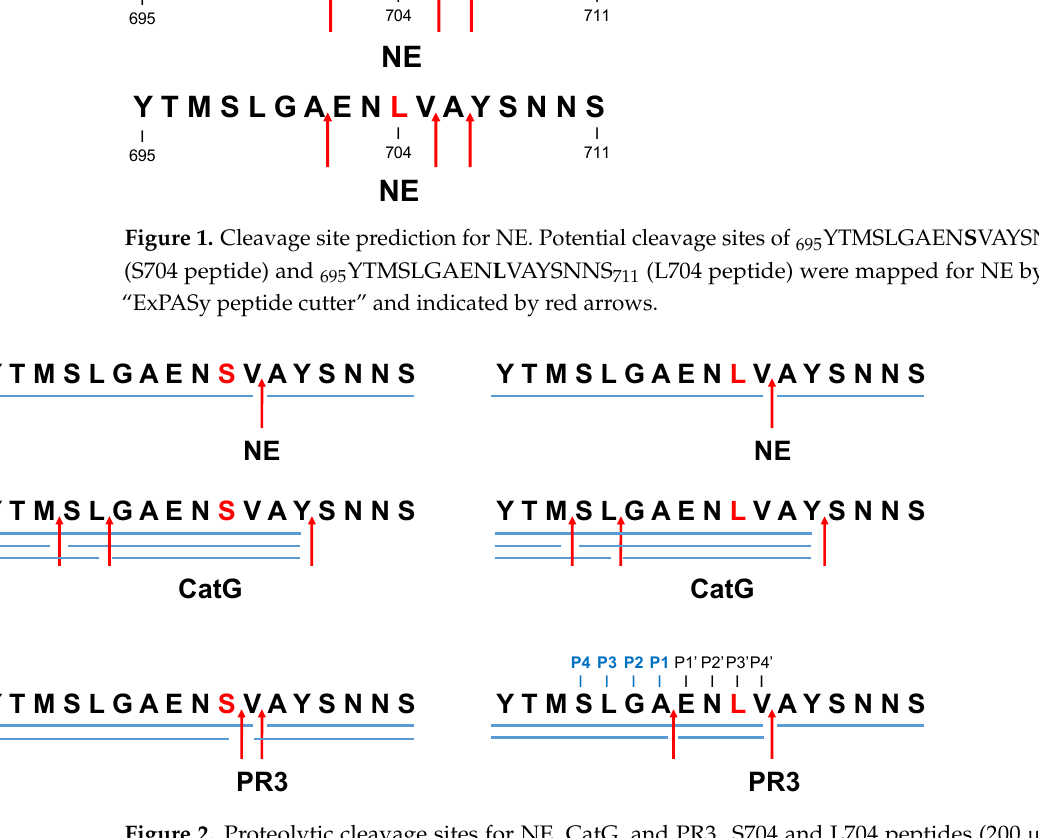
Figure 2. Proteolytic cleavage sites for NE, CatG, and PR3. S704 and L704 peptides (200 μ g/mL) were incubated with 4 μ g/mL of NE, CatG, or PR3 for 2 h at 37 °C. The hydrolysis of the peptide bonds by the indicated proteases is summarized in a digestion map, where blue bars denote the digestion pattern and red arrows the cleavage sites. Four independent experiments for HPLC (n = 4), MALDI-TOF-MS (n = 2), and HPLC-ESI-QTOF-HRMS (n = 2) were conducted.